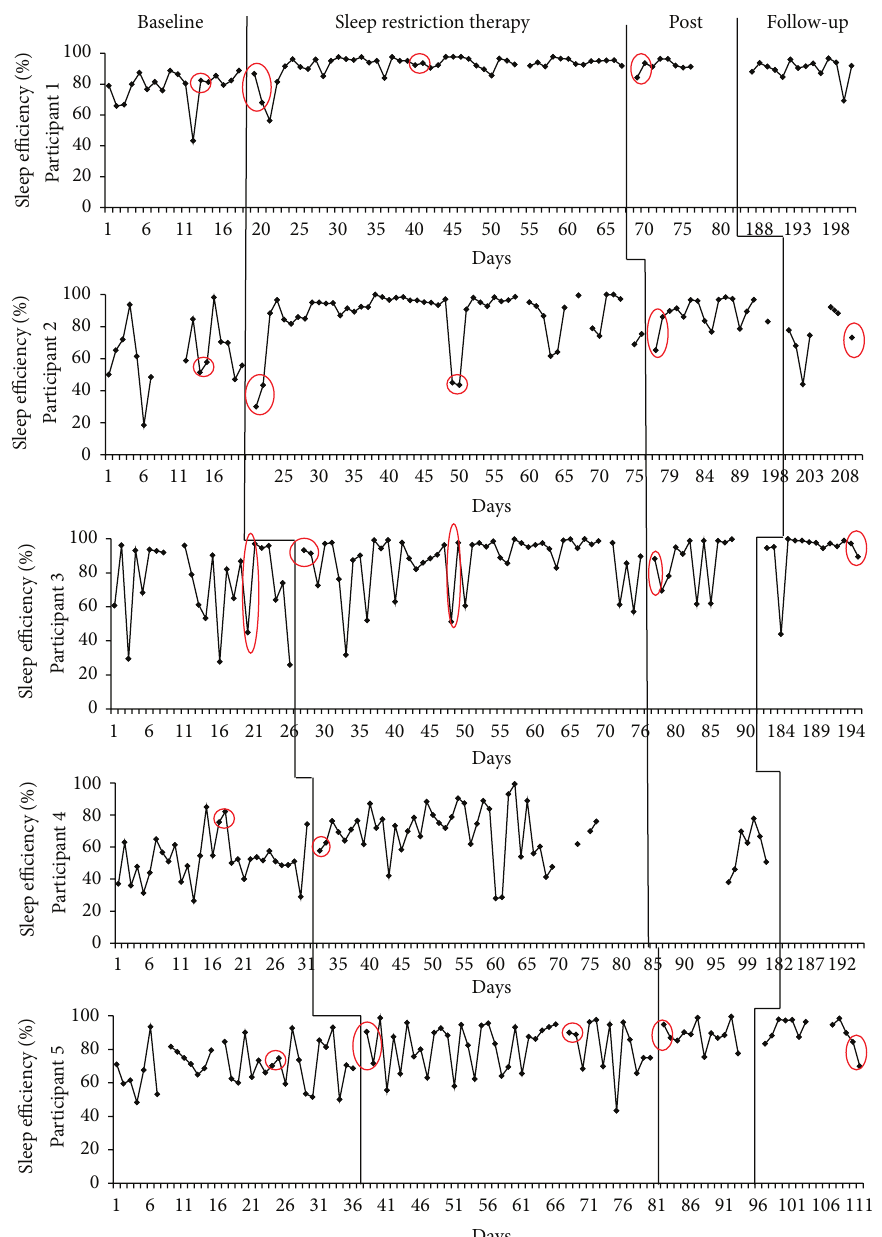
Figure 1: Daily sleep efficiency course for each participant. Circled data correspond to PSG